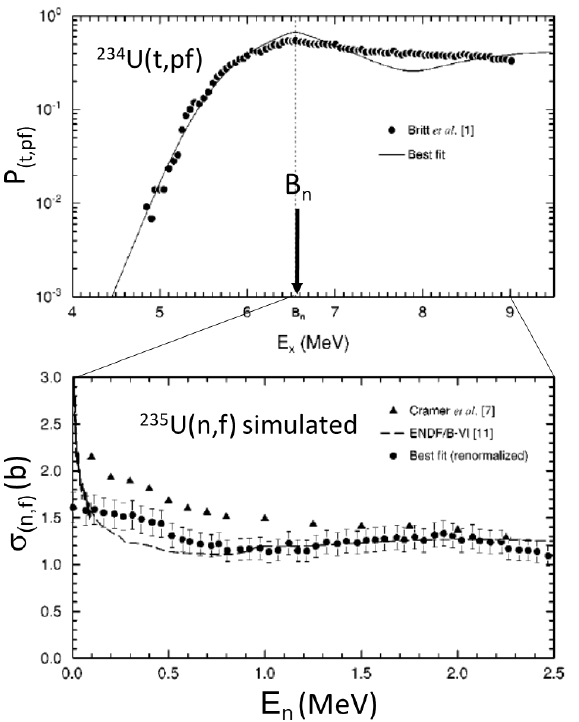
Figure 10. Top panel: The experimental fission probability mea- sured in the 234 U(t,pf) reaction (solid points) is shown as a func- tion of excitation energy in 236 U. The solid line is the best fit to these data using statistical model. Bottom panel: The derived (n,f) cross section (solid points) are compared with the ENDF- B / VI compilation of 235 U(n,f) cross sections (dashed line) and the previous surrogate result from Ref. [22] (solid